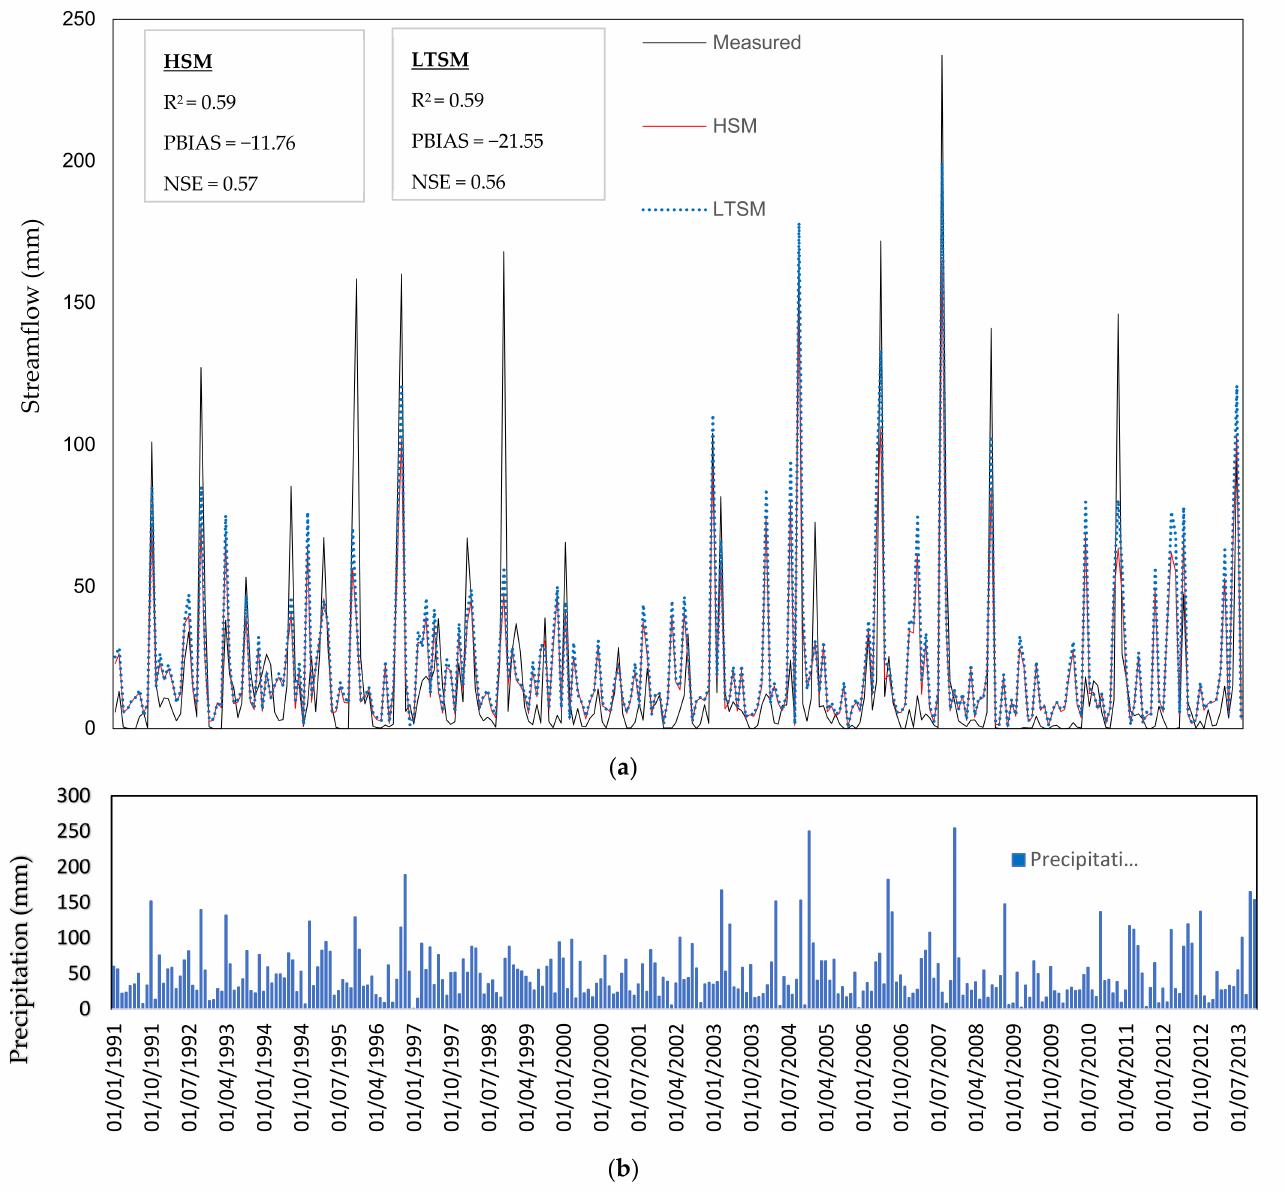
Figure 4. Comparison between the two soil datasets, ( a ) HSM (hydrological soil map) and LTSM (land-type soil map), in terms of monthly discharge simulations with SWAT for the period 1991 to 2013, together with ( b ) the monthly measured precipitation